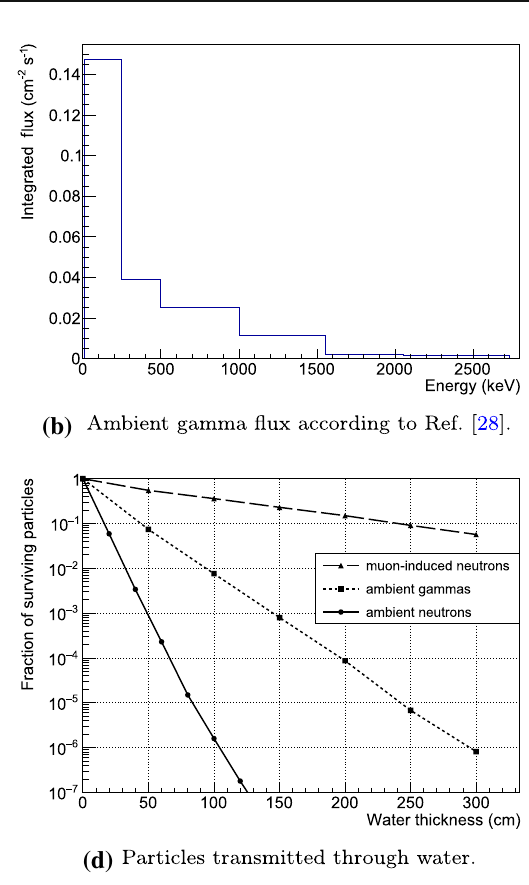
ambient neutrons are much more efficiently shielded than compara- bly high-energy muon-induced neutrons. The efficiency for shielding ambient gamma rays with water lies between the other two values